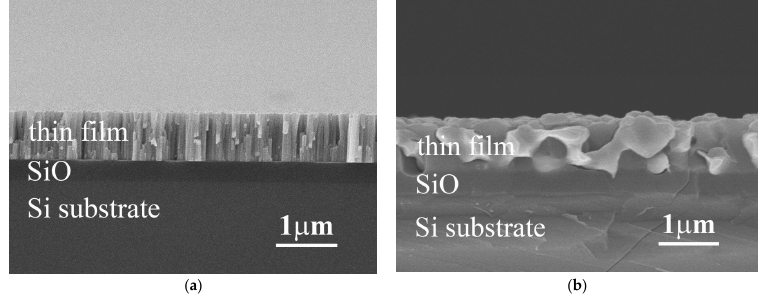
Figure 1. The typical SEM micrographs of ( a ) the as-deposited Ti 0 thin film; and ( b ) the as-annealed Ti 0.5 thin film.